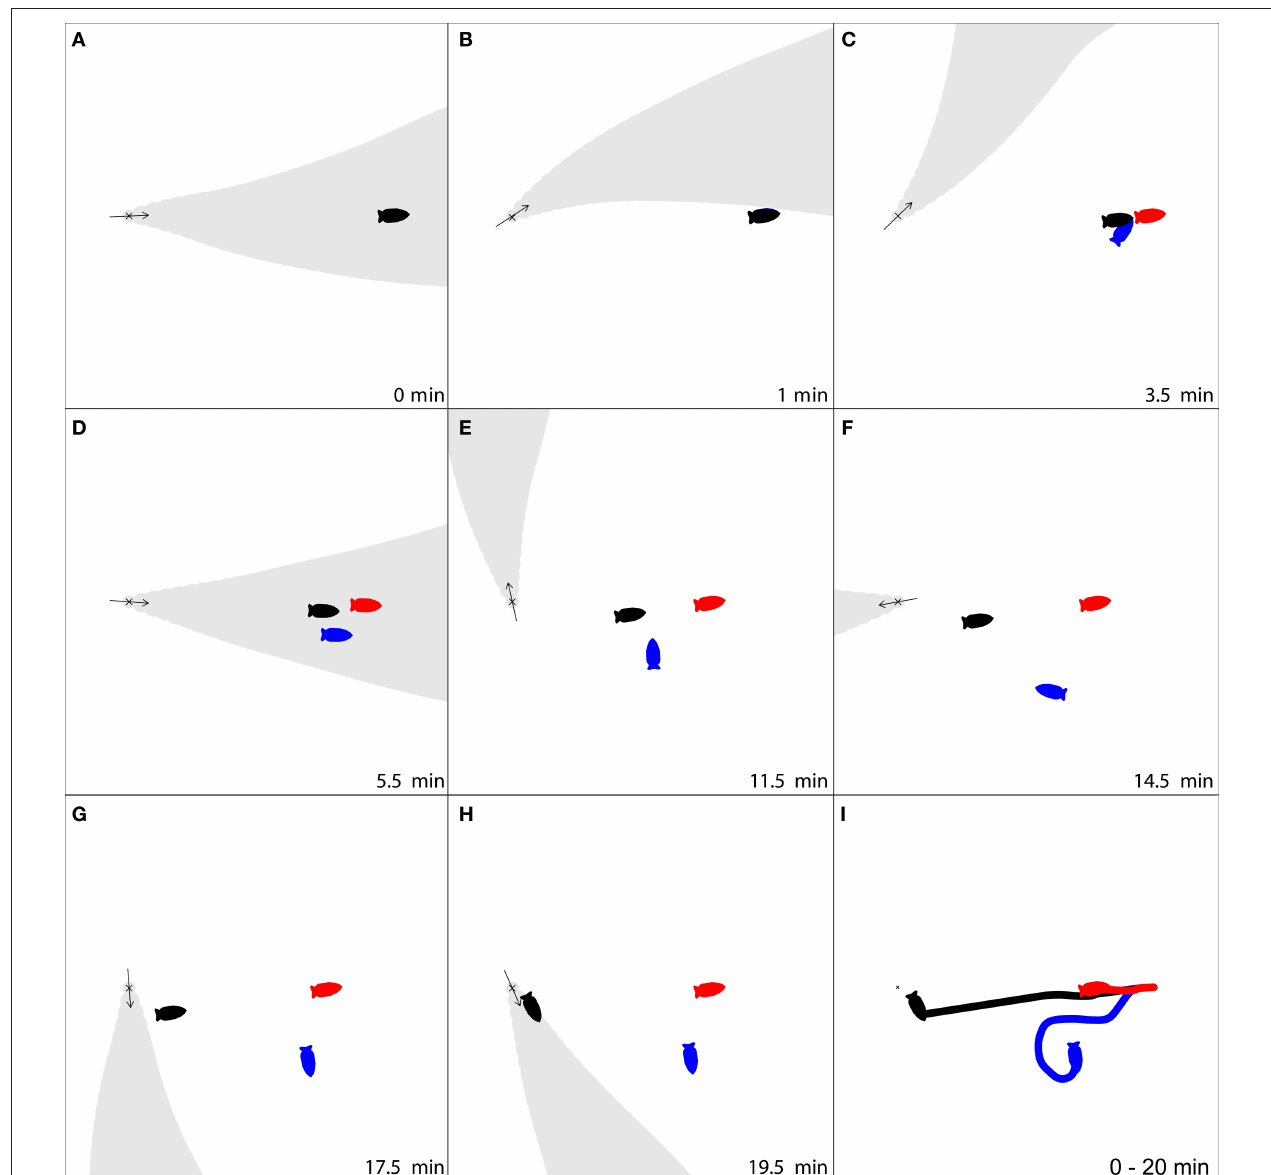
Figure 2 | An example of how switching to a magnetic compass sense can improve navigation. Three simulated Tritonia diomedea start at the same location, 2 m distant from an odor source (X), and then use three strategies for to find the source. (1) Strict odor-gated rheotaxis (OGR), stopping once the odor plume is no longer detected (red); (2) OGR followed by rheotaxis for 10 min after odors are no longer detected (blue); (3) OGR, followed by a switch to a magnetic compass sense to follow last known heading for 10 min after odors are no longer detected (black). As the simulation progresses ( A–H , time indicated in lower right for each frame), the slug using strict OGR moves only a short distance toward the target since it is only intermittently in contact with the odor